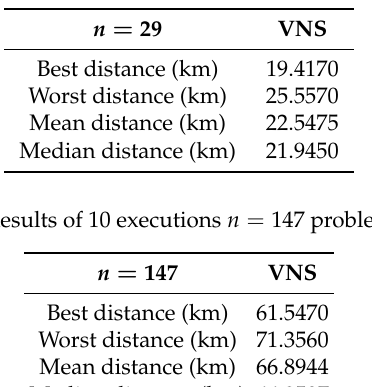
Table 3. Results of 10 executions n = 29 problem, VNS.